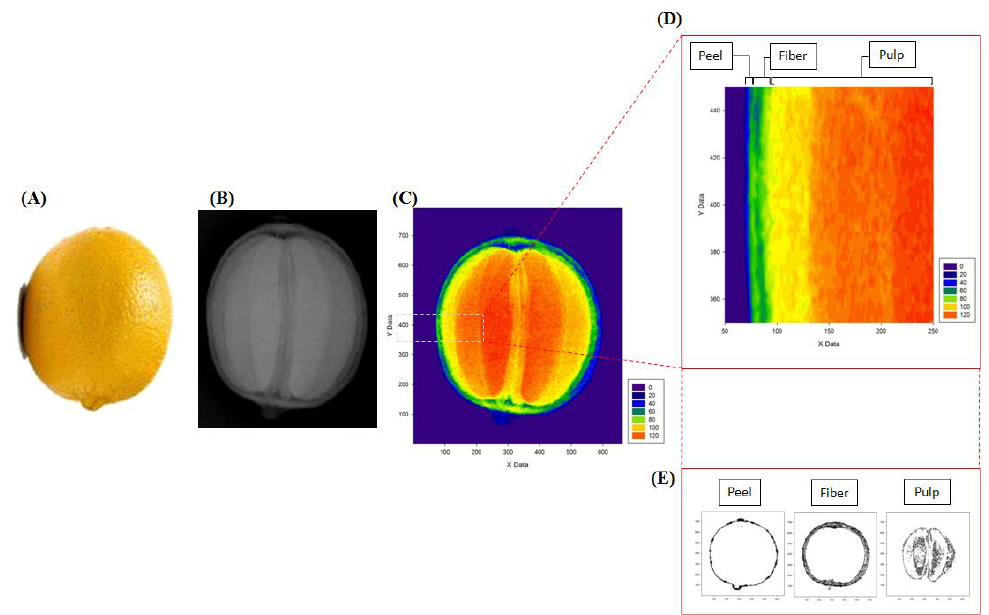
Figure 1. The process of data visualization and statistical analyses. ( A ) Real lemons; ( B ) X-ray radiographic grayscale images with Digital Imaging and Communications in Medicine (DICOM) format; ( C ) a chromatographic image showing different tissue structures of the lemons; ( D ) a zoomed-in image showing the three solid layers of tissue structures of the lemons, namely peel, fiber, and pulp; ( E ) visualized images of the stratification analysis of the grayscale data.